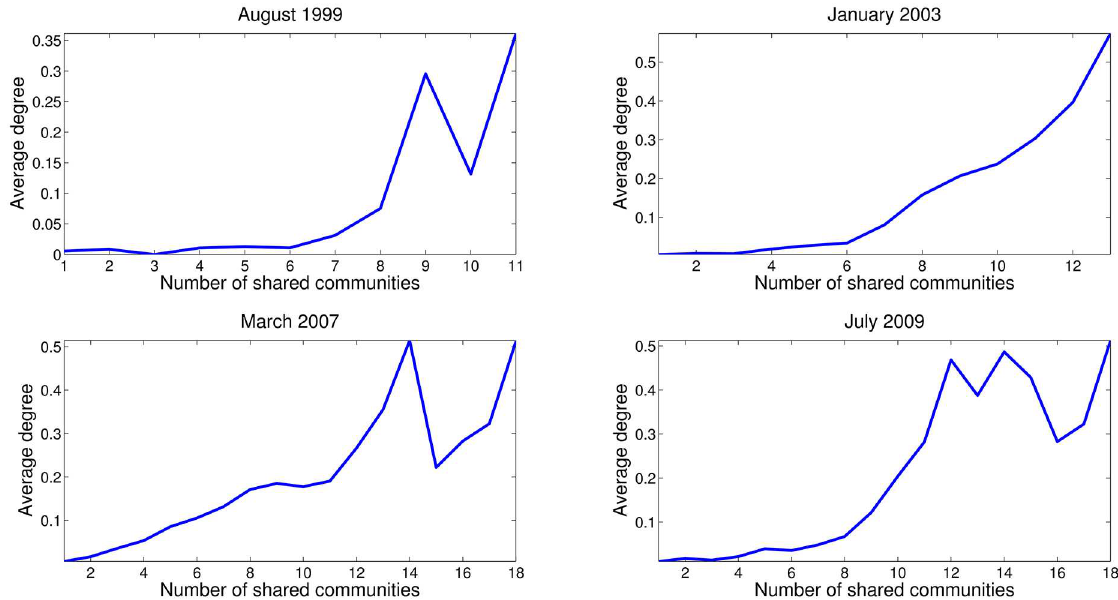
Fig 7. Averagedegree of nodes that share a given number of communities. The averagedegreeis increasingin the number of shared community. This means that nodesthat belongto overlapping communitiesare more denselyconnectedthat non overlappingparts of